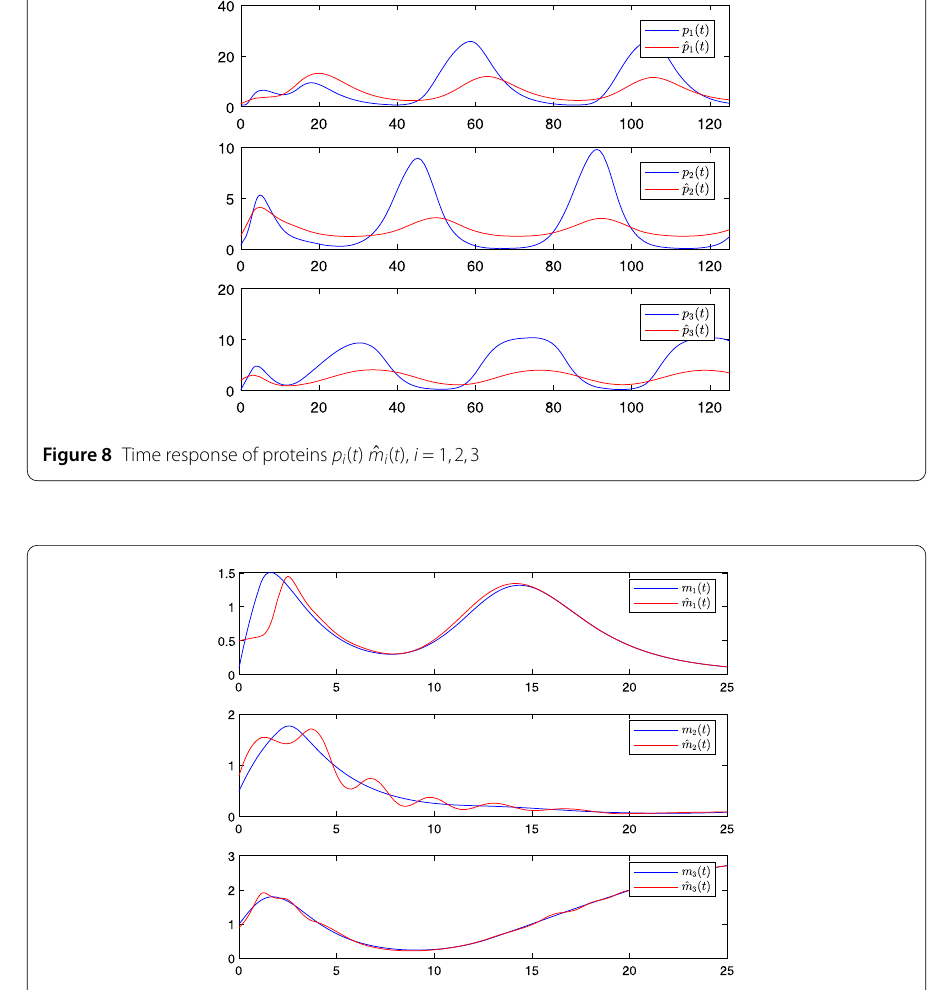
Figure 9 Synchronization behavior between mRNAs m i ( t ) and ˆ m ( t ), i =